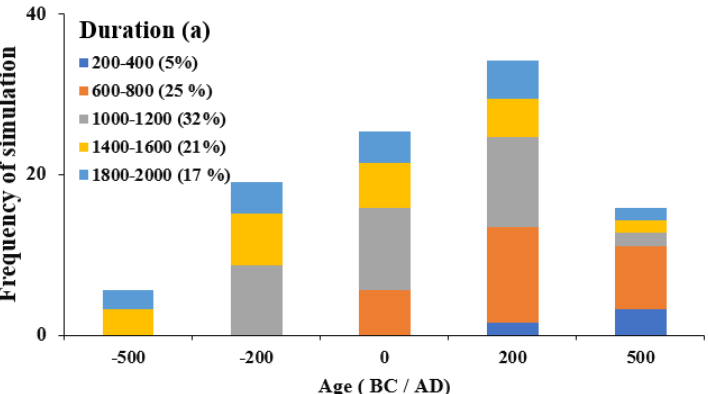
Figure 12. Histograms of the 5% best performing sedimentation models (n = 408) based on the ME (model efficiency) for floodplain sedimentation of Chencha and Dembelle. While the bars are centered at the period assumed for the start of increased sedimentation, the fill is chosen according to the assumed duration of the period with increased levels of sedimentation.